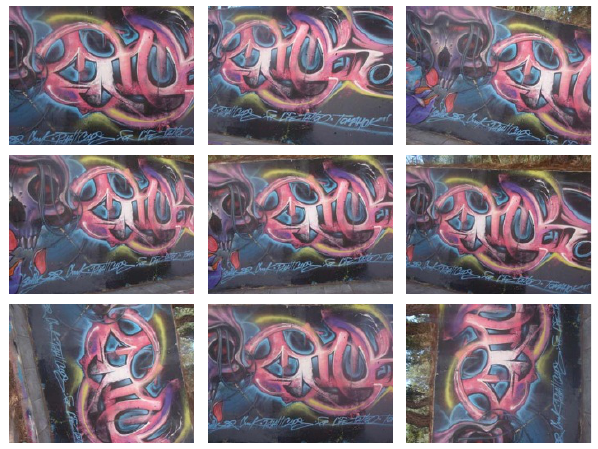
Figure 3. Image set 3 (‘fronto-parallel’ is the first image). Table 3. Calibration results for image set 3